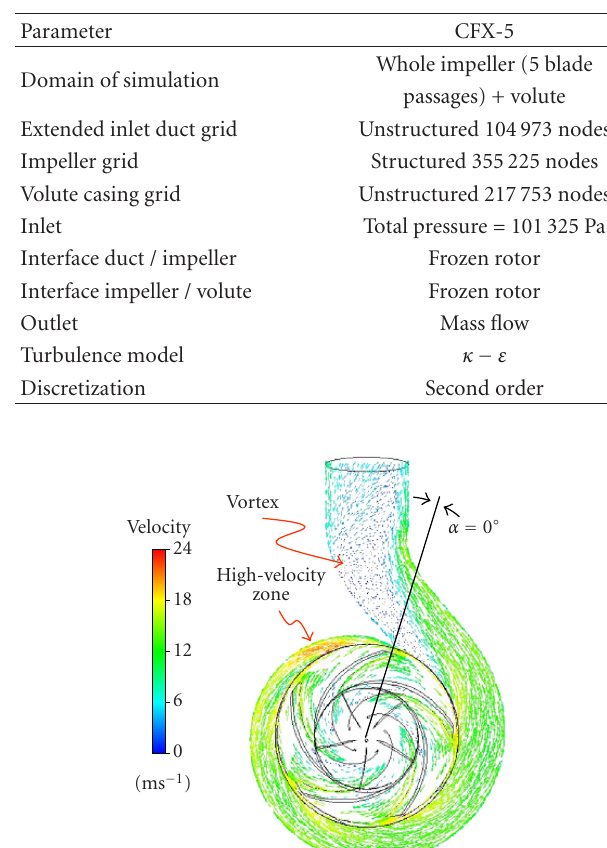
Table 5: Impeller-volute assembly simulation parameters.